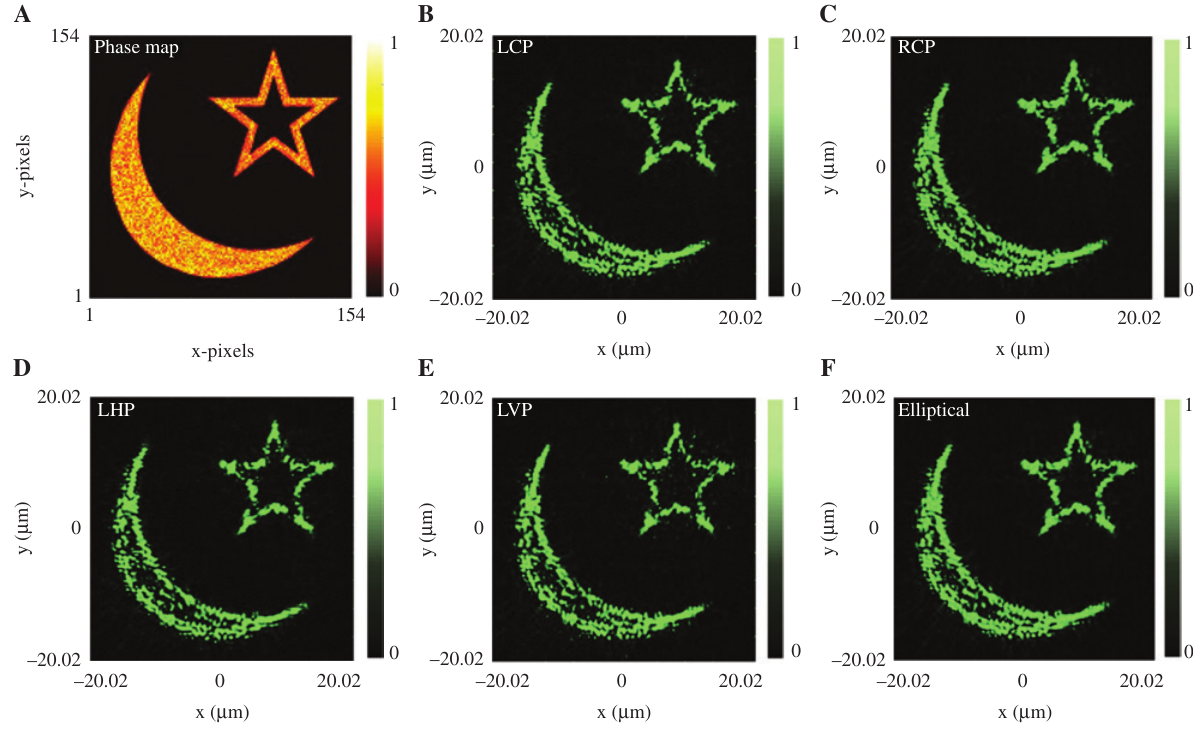
Figure 3: Demonstration of the polarisation-insensitive metahologram via the reconstruction of a single holographic image. (A) Desired phase map of the target image (moon and star) with 154 × 154 pixels. The size of each pixel is 260 nm. Reconstruction of holographic images at a wavelength of 532 nm under (B) LCP (C) RCP (D) LHP (E) LVP and (F) elliptically polarised incidence. The results are obtained using finite difference time domain solver (FDTD Lumerical) with perfect matching layer boundary conditions in the x, y and